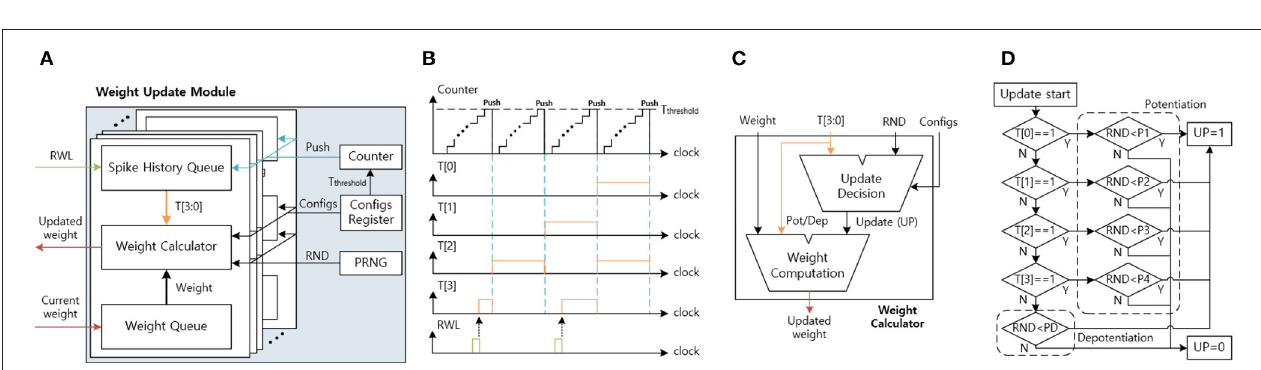
FIGURE 12 | (A) The weight update module architecture. (B) The spike history queue function graph. (C) The weight calculator architecture. (D) The update decision module’s state machine for stochastic